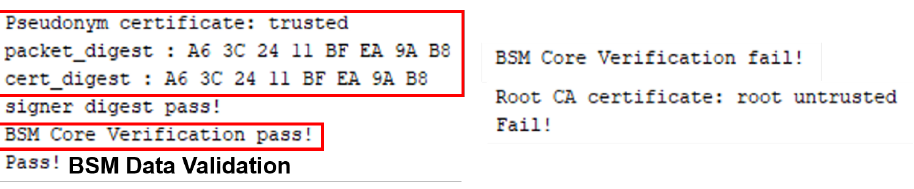
Figure 14. Result of verifying the core data and certificate of the BSM that the evaluation target node sent. The verification is passed only if both items are